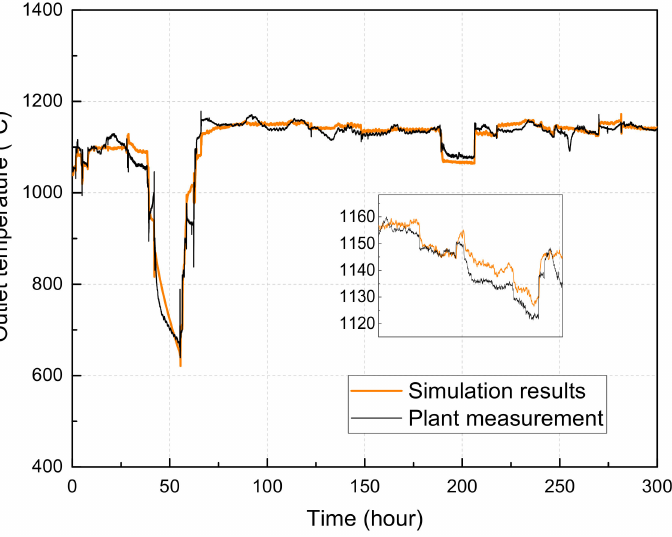
Figure 8. Measured and predicted temperature value at the outlet of the combustion